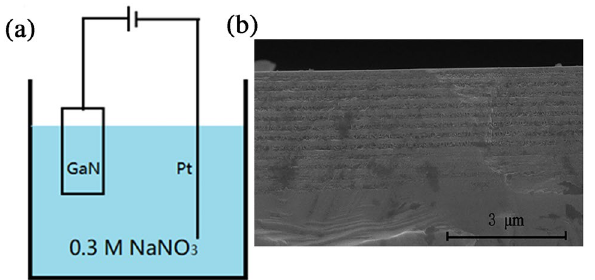
Figure 1. ( a ) Schematic diagram of the EC etching setup. ( b ) Cross-sectional image of GaN-based sample after the etching measured by scanning electron